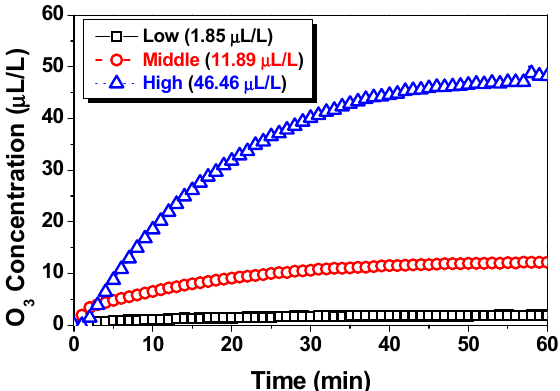
Figure 4. O 3 concentration variations depending on different plasma treatment conditions that were measured. The values in the legend of the graph represent the averaged concentration value of each condition from 40 to 60 min.